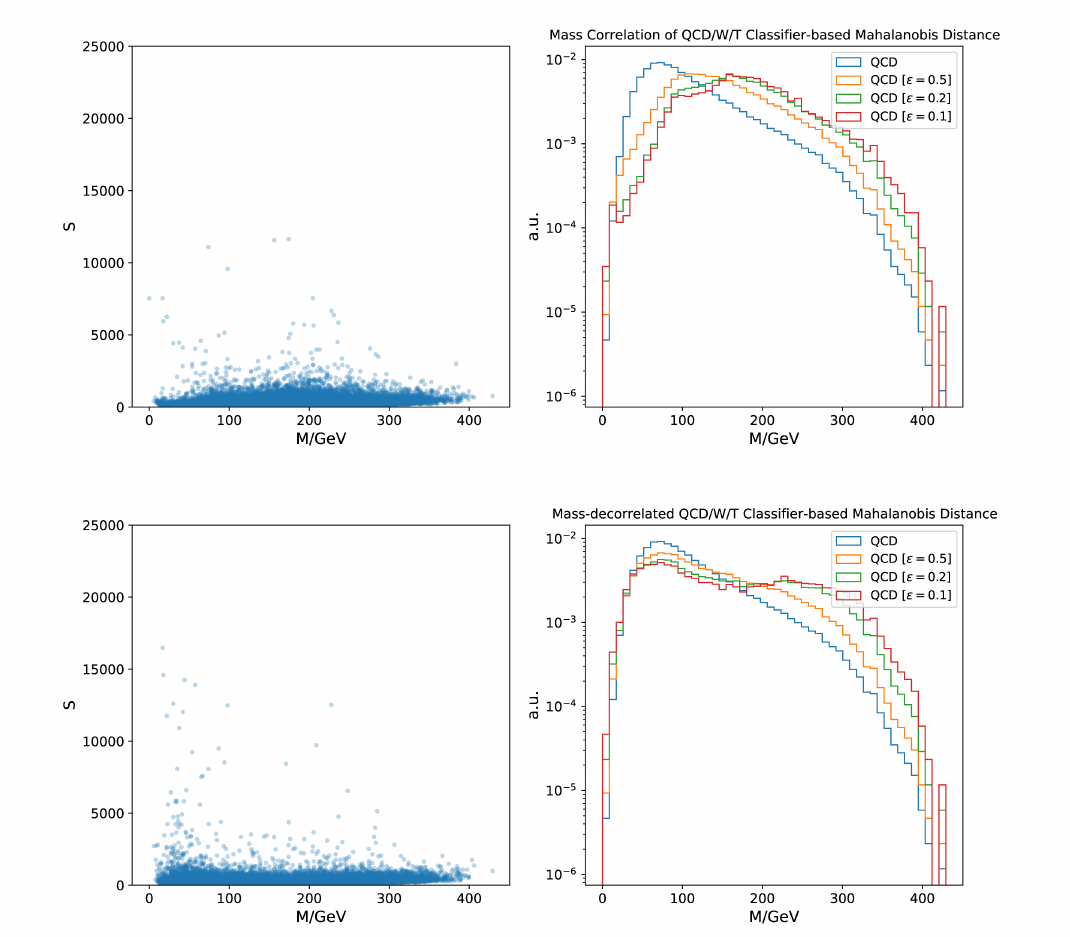
Figure 10 . Ensemble Model. Top : The un-decorrelated model with the Mahalanobis distance as the anomaly score. Bottom : The mass-decorrelated model with the Mahalanobis distance as the anomaly score. Left : The correlation between jet mass M and the anomaly score. Right : Mass distributions for different background acceptance rates ( (cid:15)